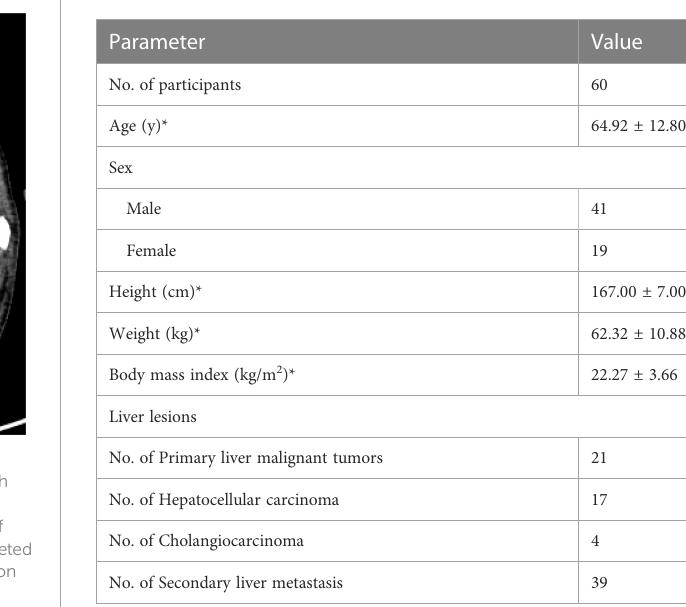
TABLE 1 Participant and lesion characteristics.